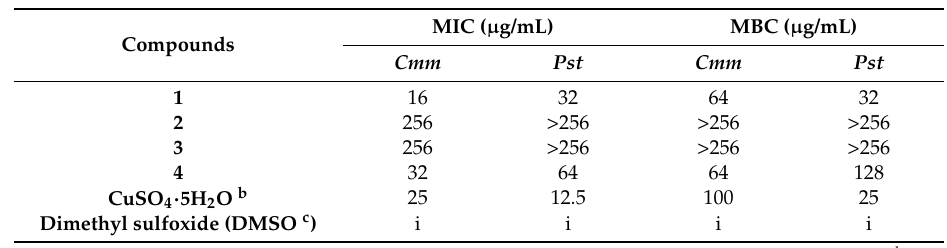
Table 1. Minimal inhibitory concentrations (MIC) and minimum bactericidal concentrations (MBC) values a of compounds 1 – 4 against bacterial strains.